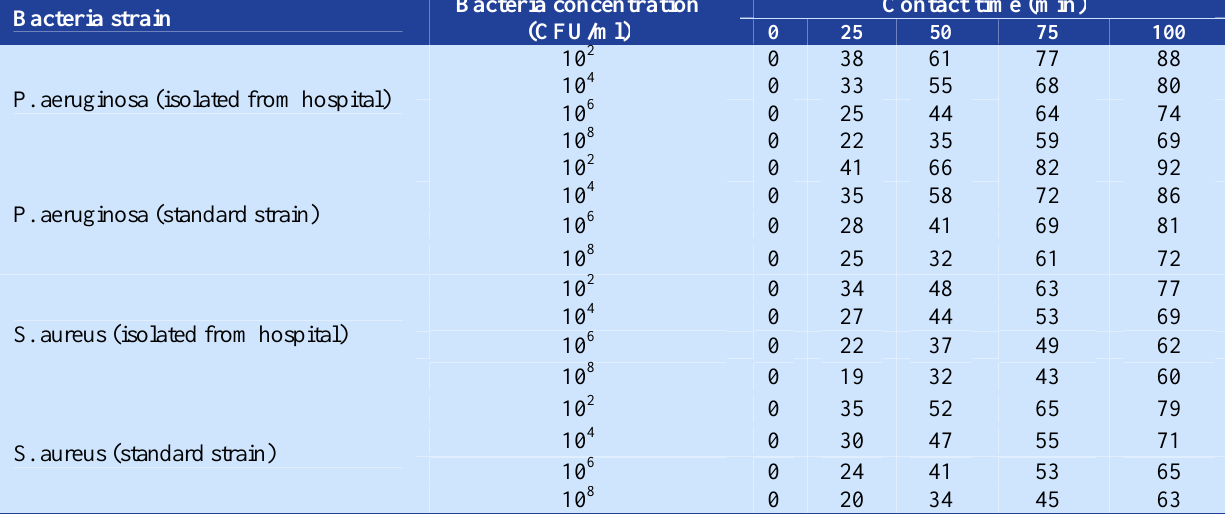
Table 1. Removal percentage of P. aeruginosa and S. aureus using ultrasonolysis process under different conditions Bacteria strain